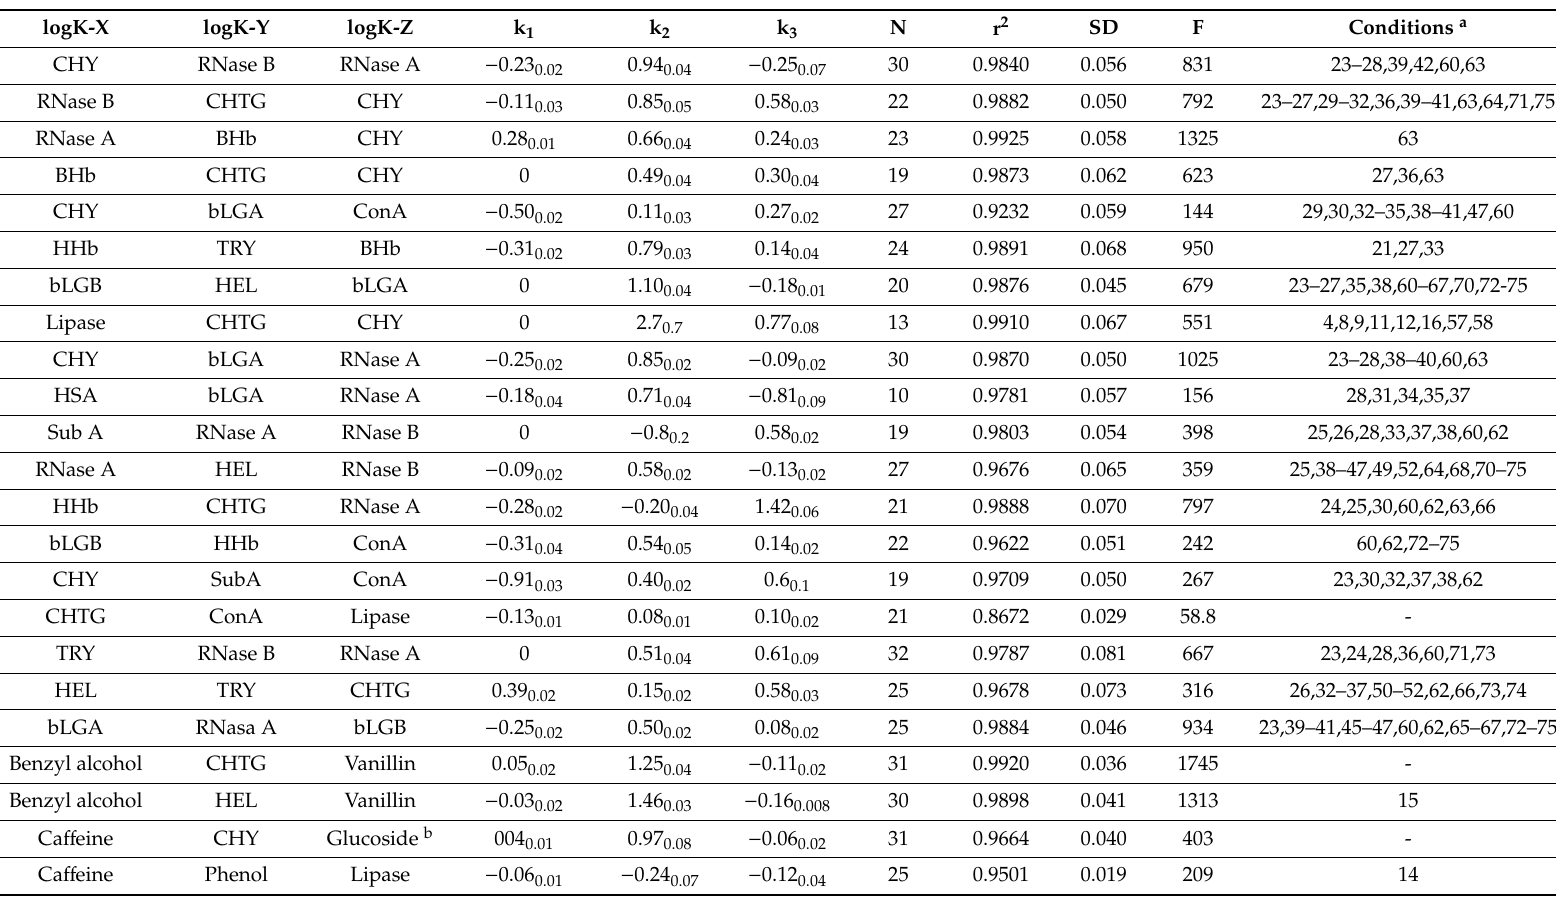
Table 2. Coe ffi cients and statistical characteristics of linear relationships between logarithms of partition coe ffi cients for various proteins * (see Table S2) and between logarithms of partition coe ffi cients for two small compounds and one protein in ATPS of di ff erent polymer and ionic compositions (data see Tables S1 and